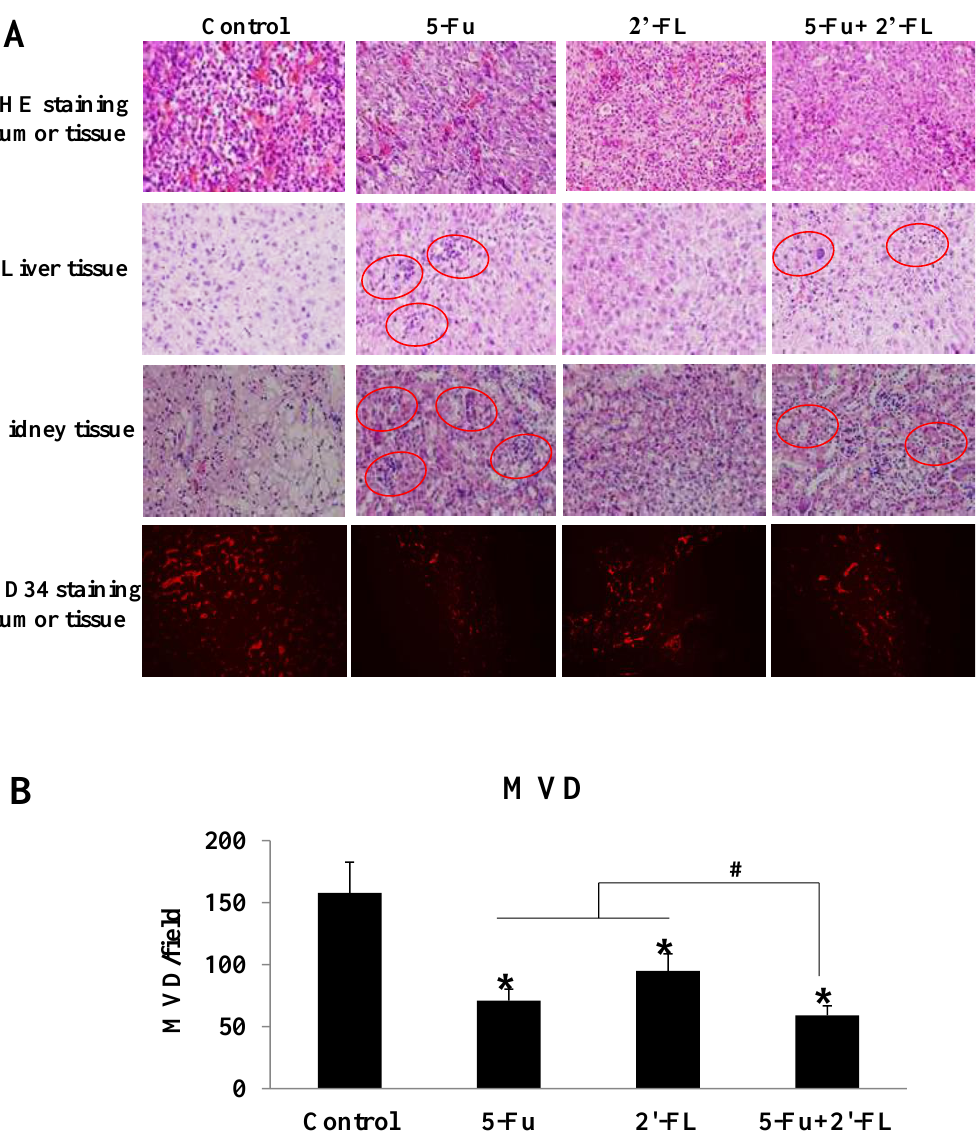
Figure 4. The effect of 2′ -FL on HCT116 tumor angiogenesis detected by CD34 staining. ( A ) HE staining of HCT116 tumor tissue, liver tissue, and kidney tissue, as well as CD34 staining of HCT116 tumor tissue. ( B ) The microvessel density (MVD) of HCT116 tumor tissue by CD34 staining. The data are presented as mean ± SD, * p < 0.05 compared with the control group, and # p < 0.05 compared with (5-Fu+ 2′ -FL) group, n = 3.